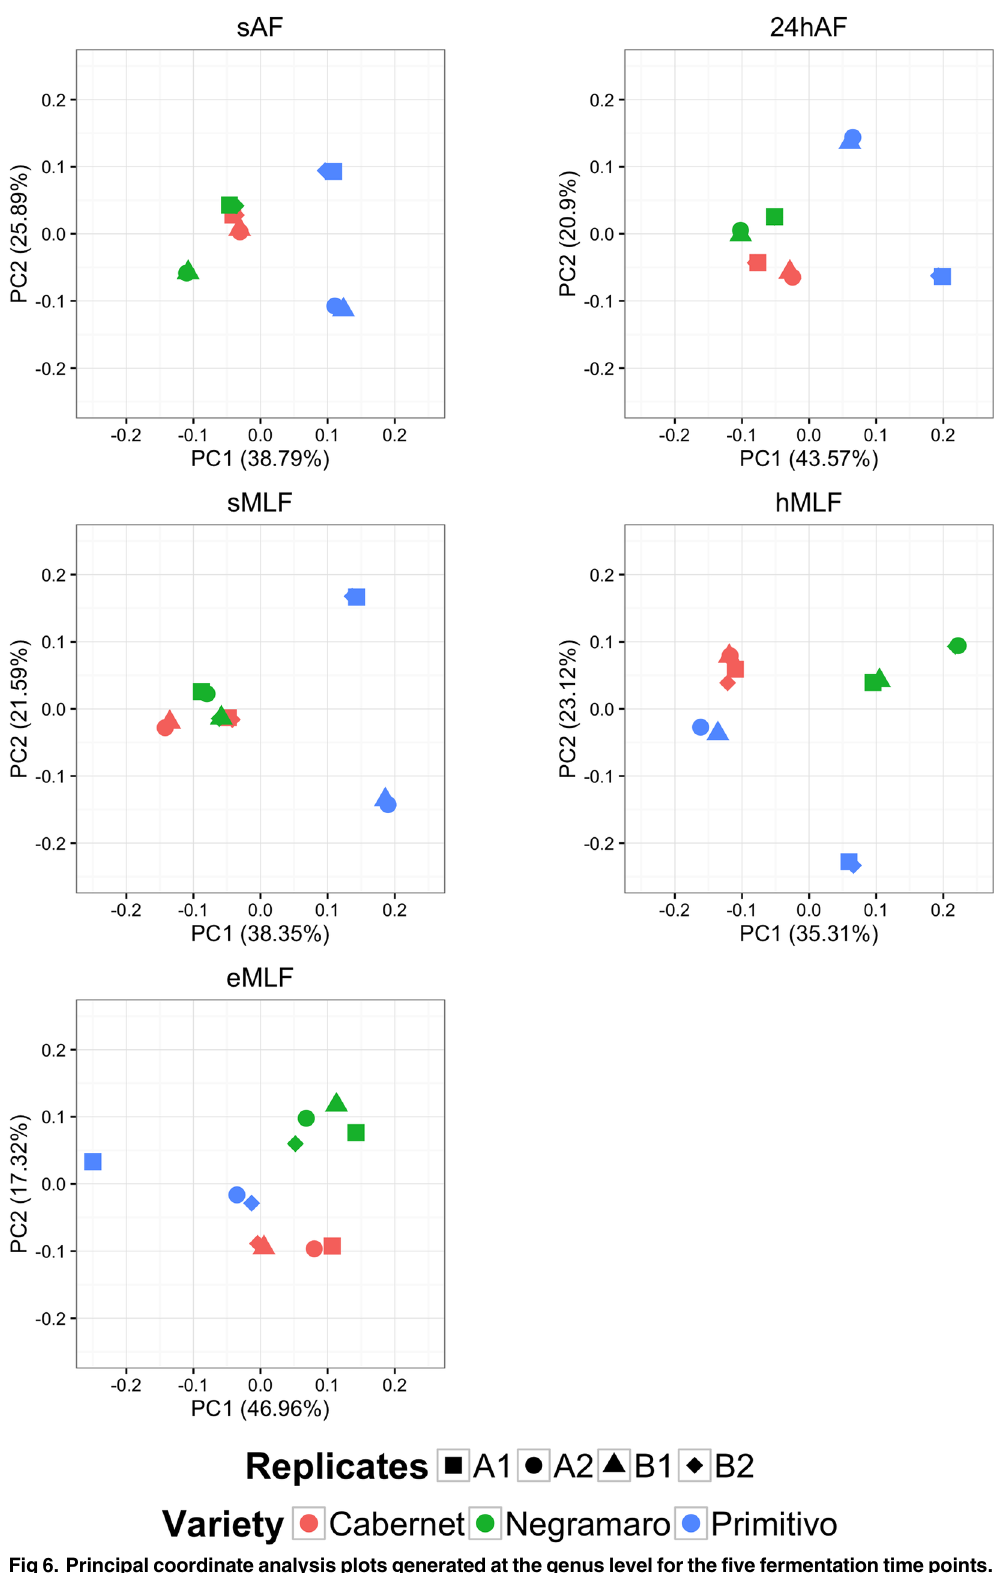
Fig 6. Principal coordinate analysis plots generated at the genus level for the five fermentation time points. Principal coordinate analysis (PCoA) plots based on the taxonomical classification at the genus level are shown for the five tested time points: sAF , 24hAF , sMLF , hMLF , and eMLF . Biological replicates (1 and 2) and